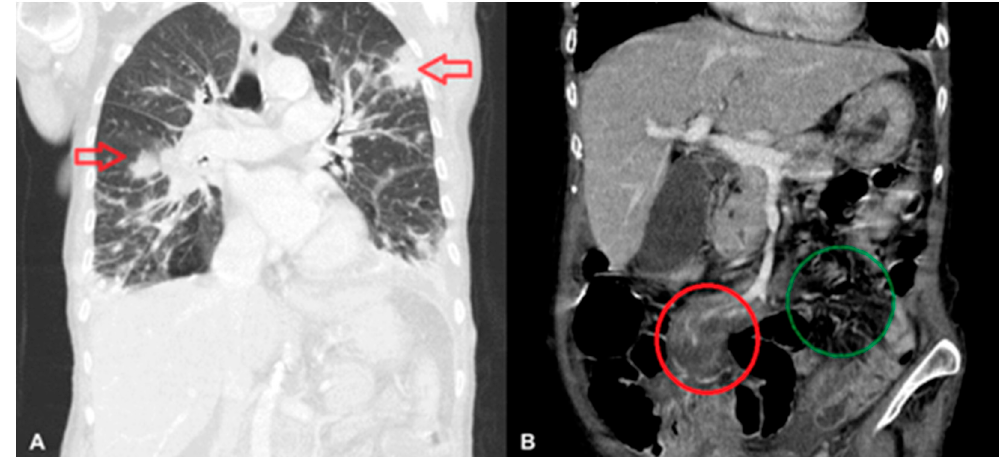
Figure 1. Lymphomatous infiltration of the lungs (indicated by arrows) ( A ), and of the mesentery of the small intestine (in the red circle); the right mesentery is shown in the green circle ( B ).